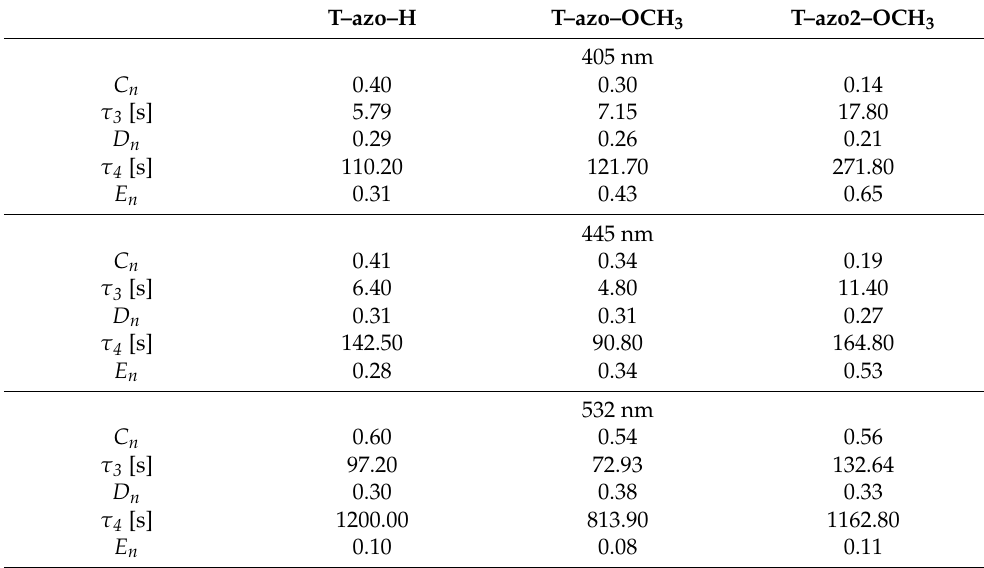
Table 2. Fitted parameters for the birefringence relaxation of T–azo–H, T–azo–OCH 3 and T–azo2– OCH 3 for 405 nm, 445 nm and 532